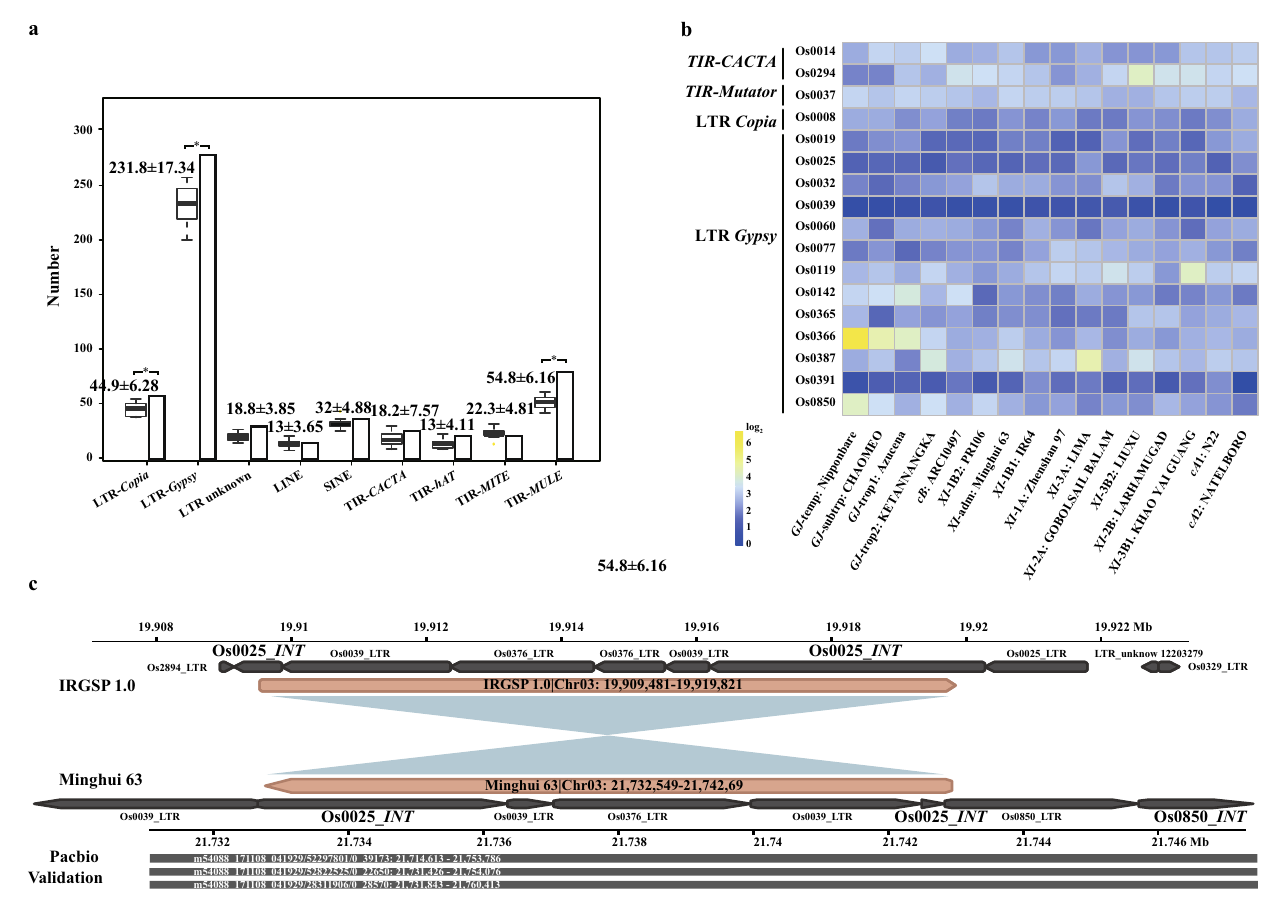
Fig. 5 | Transposable element analysis of the pan-genome inversions index of rice. a The amount (y-axis) of different transposable element (TE) families (x-axis) show that three TE families (i.e., LTR-RT Ty1- copia , Ty3- gypsy and DNA-TE MULE) were observed in higher frequencies at the breakpoints of the pan-genome inver- sion index than the resampled control tests. Box- and bar-plots show the fre- quencies of TEs observed at the breakpoints of random resampled regions ( n =10 biologically independent resamples) and the pan-genome inversion index,